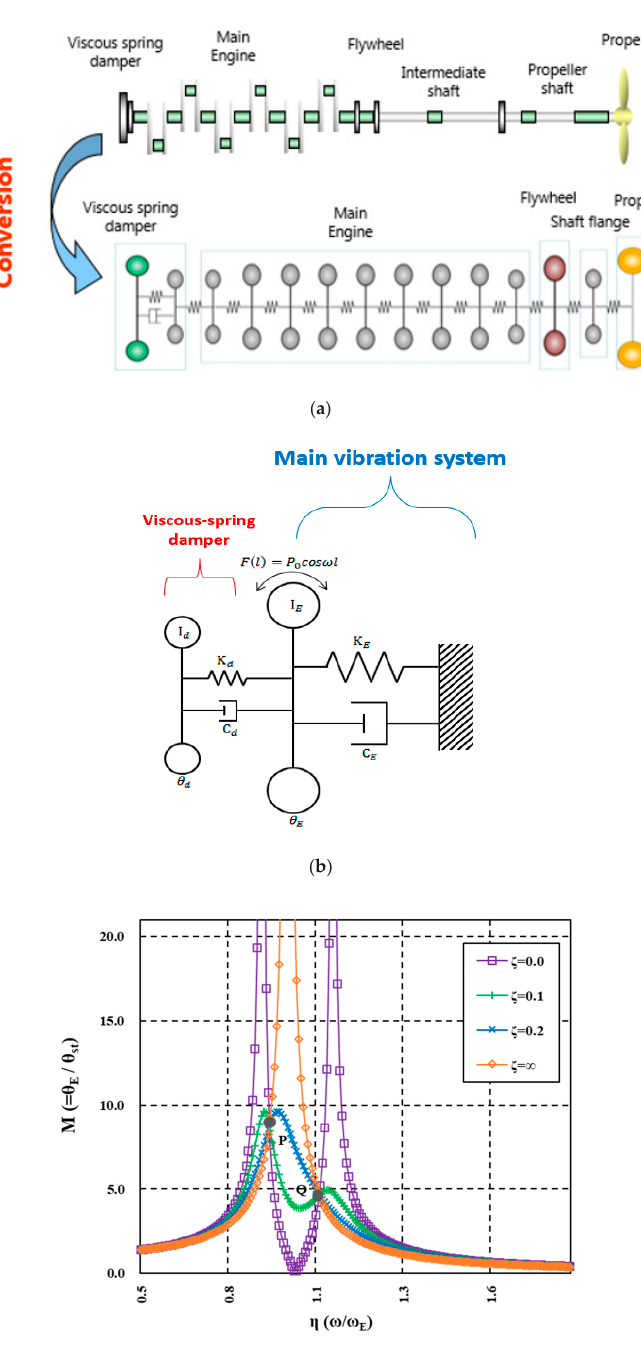
Figure 4. ( a ) Multi degree modeling of the propulsion shafting system in a ship ( b ) Equivalent mass-spring system with viscous-spring damper. ( c ) E ff ect of a viscous-spring damper on the response of a vibratory